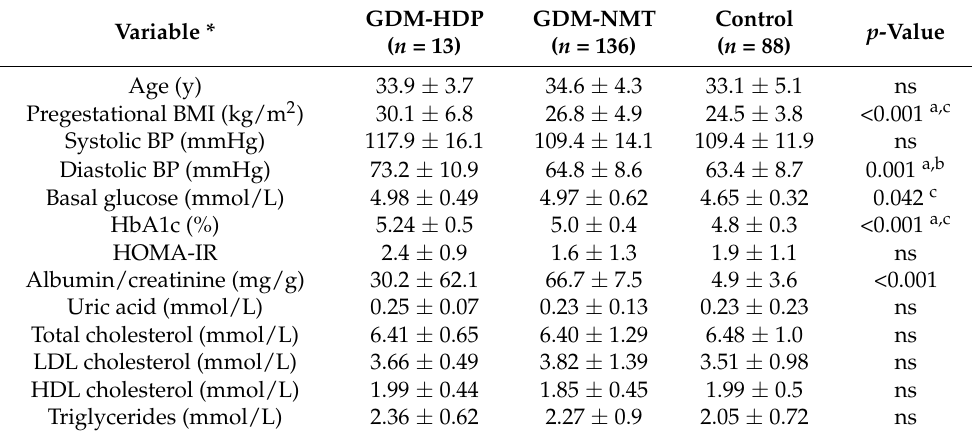
Table 1. Demographic, clinical, and laboratory variables at the time of inclusion.